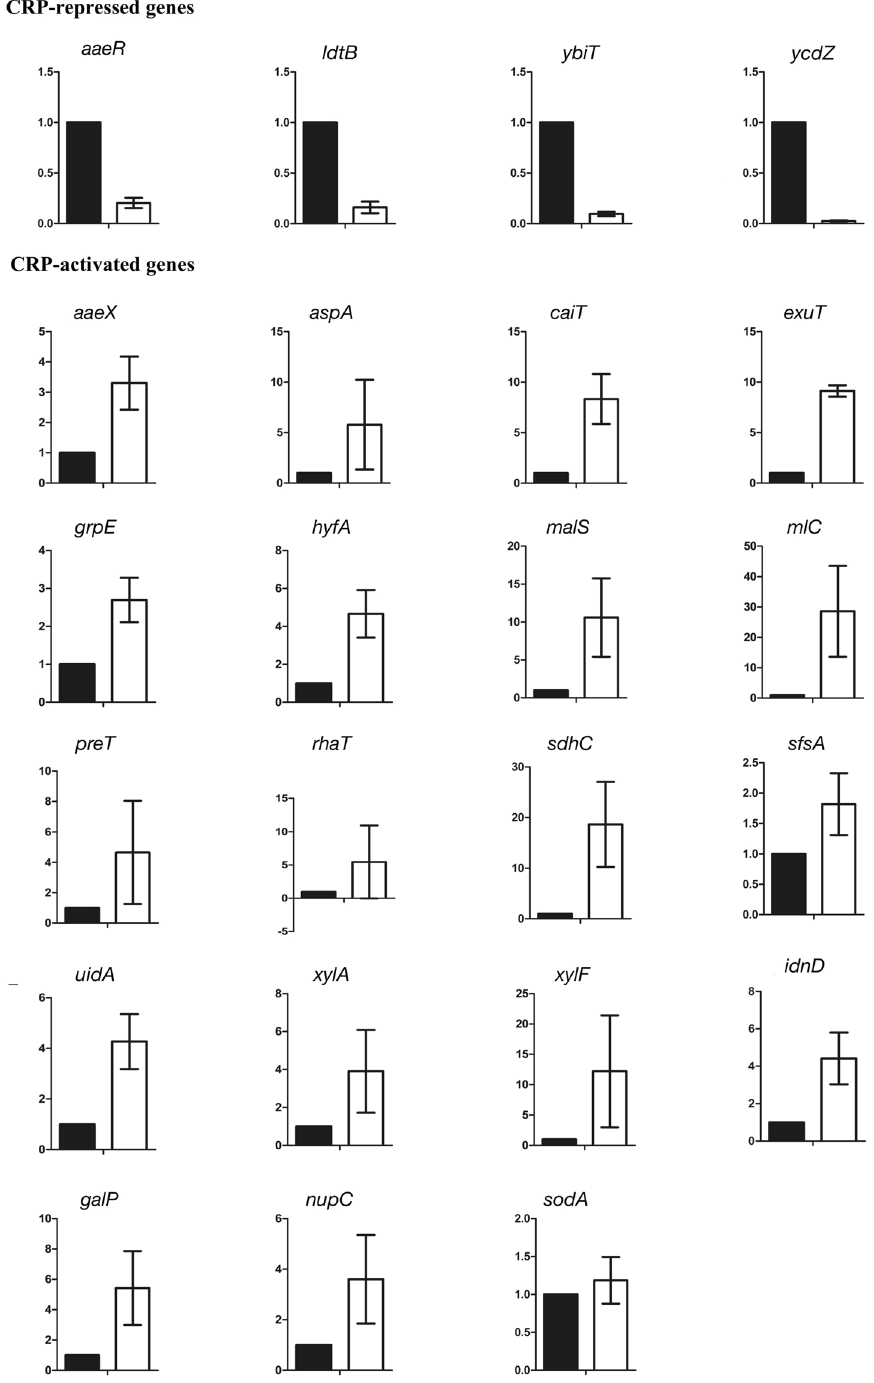
Figure 4. The quantitative PCR experiments for determining the regulatory roles of CRP on the 23 previously unobserved regulatory interactions in E. coli . The y-axis represents the relative quantity. The whiskers are the standard deviation of relative quantity. The black bars belong to the control group (0 mM cAMP concentration), and the white bars belong to the case group (1 mM cAMP